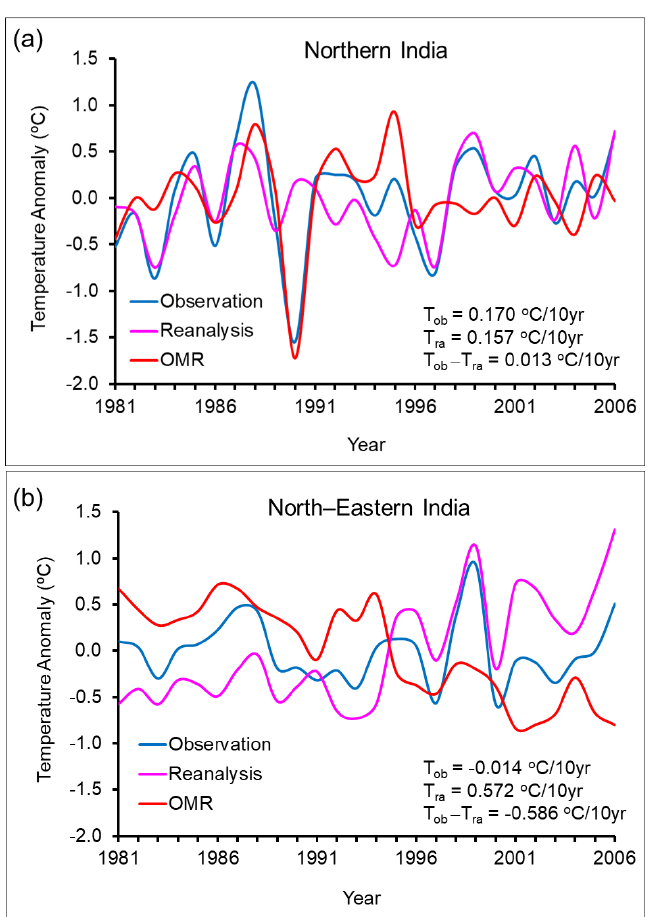
Figure 3. The temperature anomalies over ( a ) NI and ( b ) NEI for the period 1981–2006 derived from the observation, reanalysis and observation minus reanalysis (OMR).